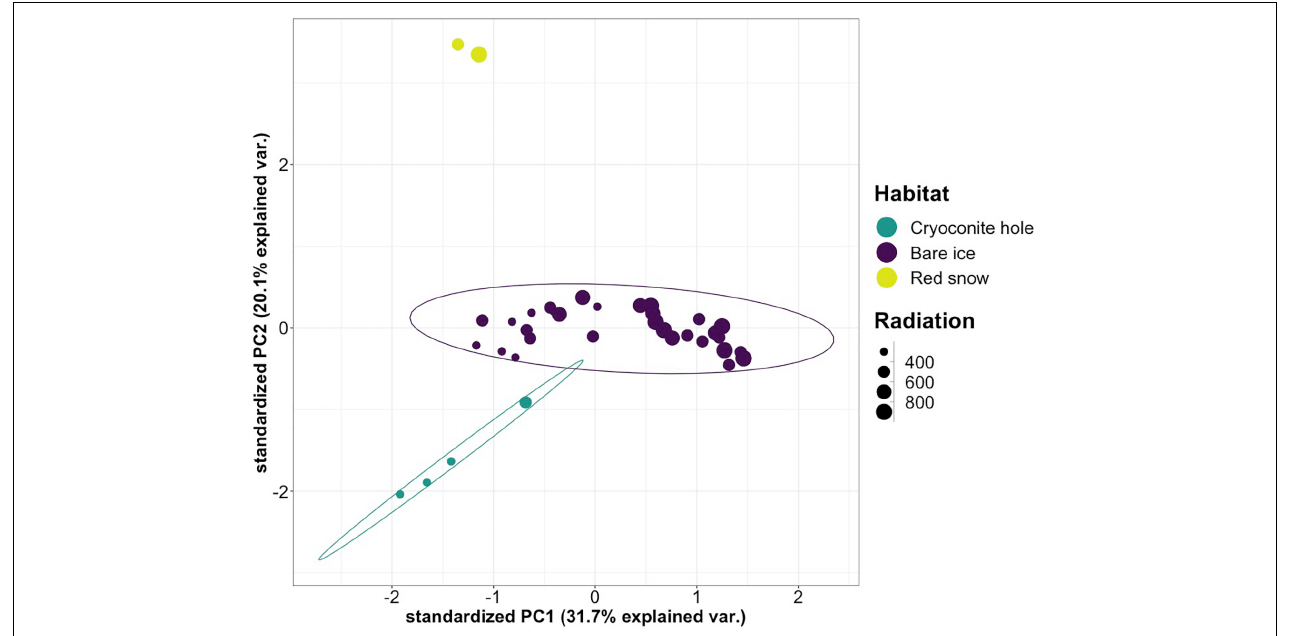
FIGURE 3 | Principal component score plot for the PCA of emission rates per compound from cryoconite holes, bare ice, and red snow. Data points are sized according to the average incoming shortwave radiation in W m − 2 at the time of sample collection. The 95% confidence ellipses are marked for cryoconite holes and bare ice, but not for red snow due to the limited number of samples ( n = 2). For the corresponding loading plot, see Supplementary Figure 1 .